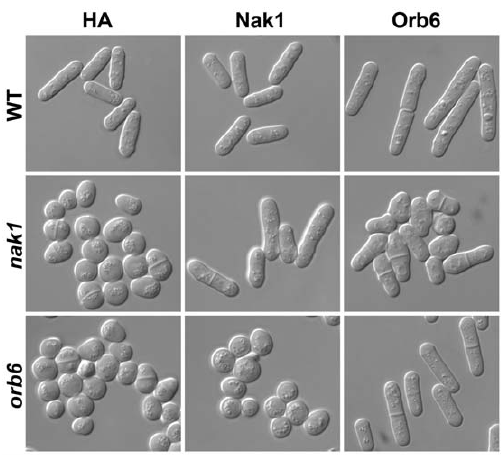
Figure 2. Orb6 overexpression partially rescues the nak1 ts polarity defect. HA-Nak1 or HA-Orb6 were expressed in WT (SP199), nak1 and orb6 ts cells as described in Figure 1. Cells were grown in thiamine free liquid PMAU media to an O.D. =1.0 at 33 u C and examined by DIC microscopy.